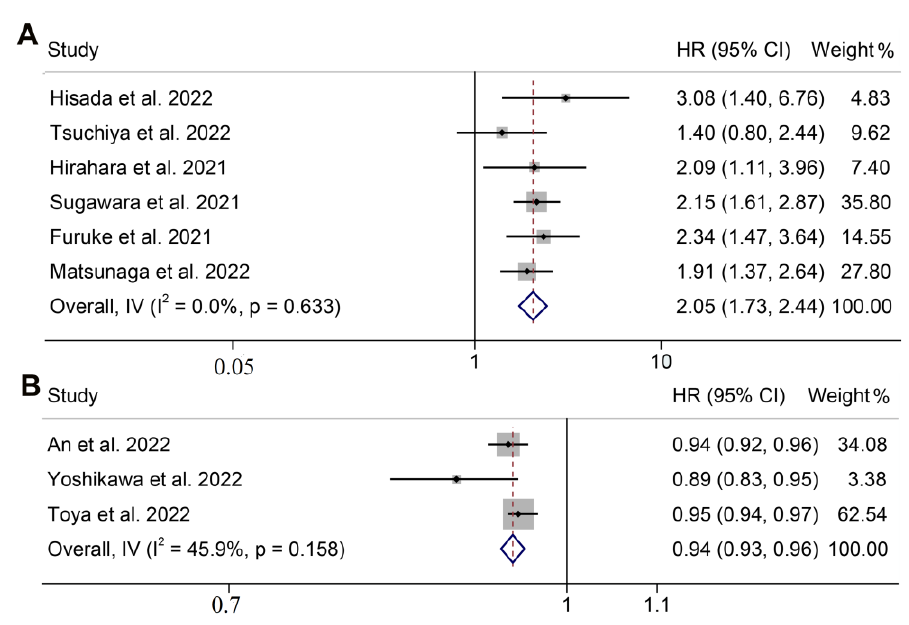
Figure 2. Meta-analysis of overall survival. Forest plot of the GNRI (dichotomous variable) in relation to overall survival ( A ). Forest plot of GNRI (continuous variable) in relation to overall survival ( B ). HR, hazard ratio; CL, confidence interval; GNRI, geriatric nutrition risk index [13–21].